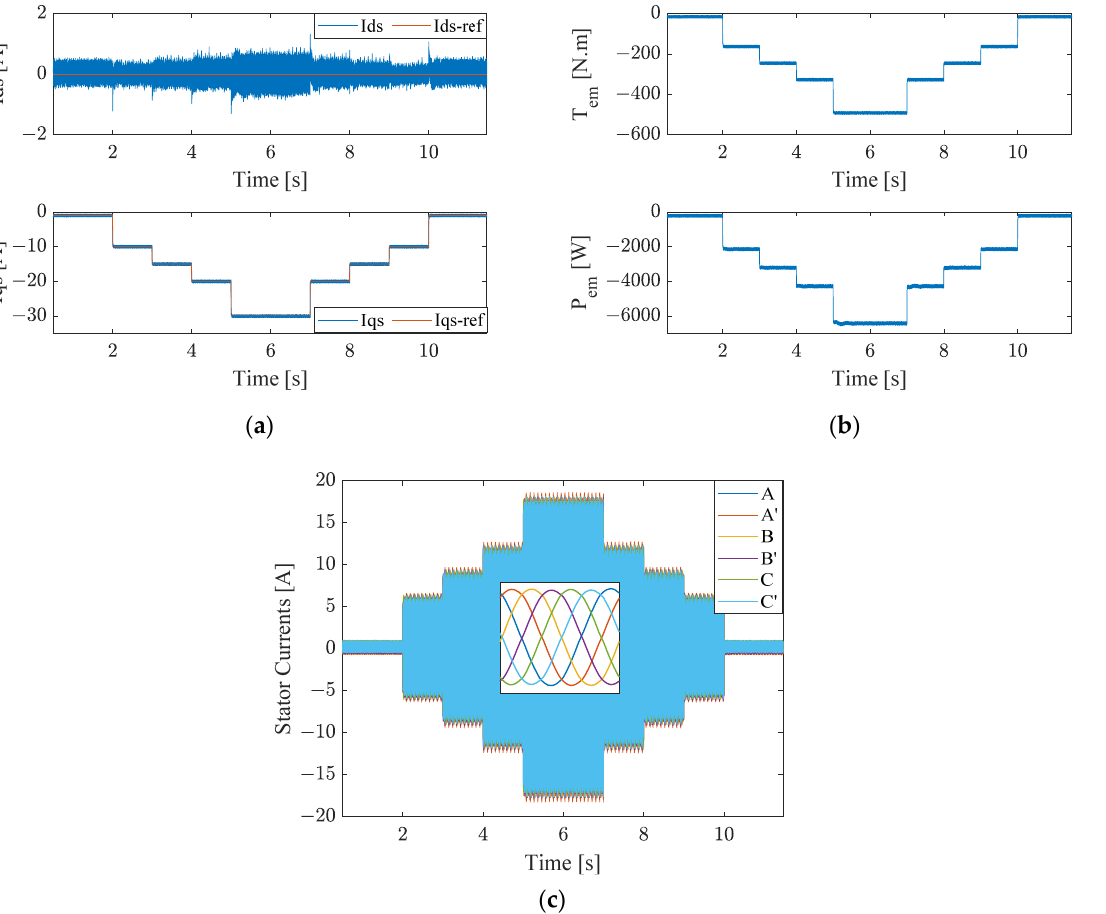
Figure 8. Healthy mode results with FLC controller: ( a ) dq currents; ( b ) electromagnetic torque and electromagnetic power; ( c ) stator currents.